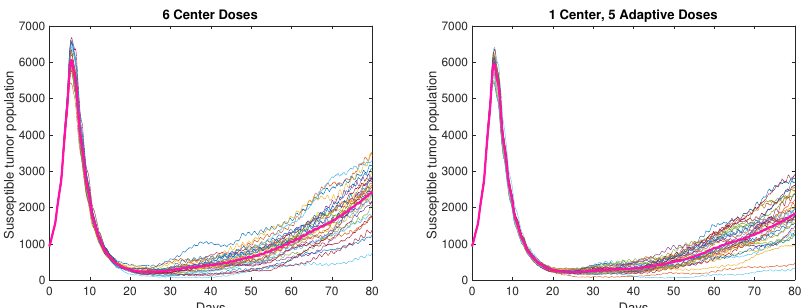
Figure A1. All simulations for a AT = 0.07, with the thicker pink curves denoting the mean of the trajectories. The left figure shows the simulations with 6 center viral doses administered, and the right figure shows the simulations with 1 center and 5 adaptive doses administered.